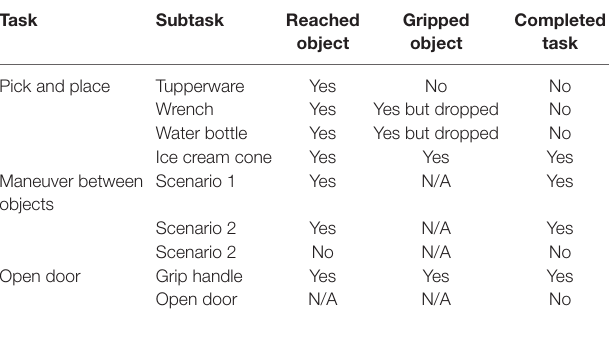
TaBle 2 | a list of tasks in the manipulation challenge portion of the robosoft grand challenge and the performance of the active gripper. Task subtask